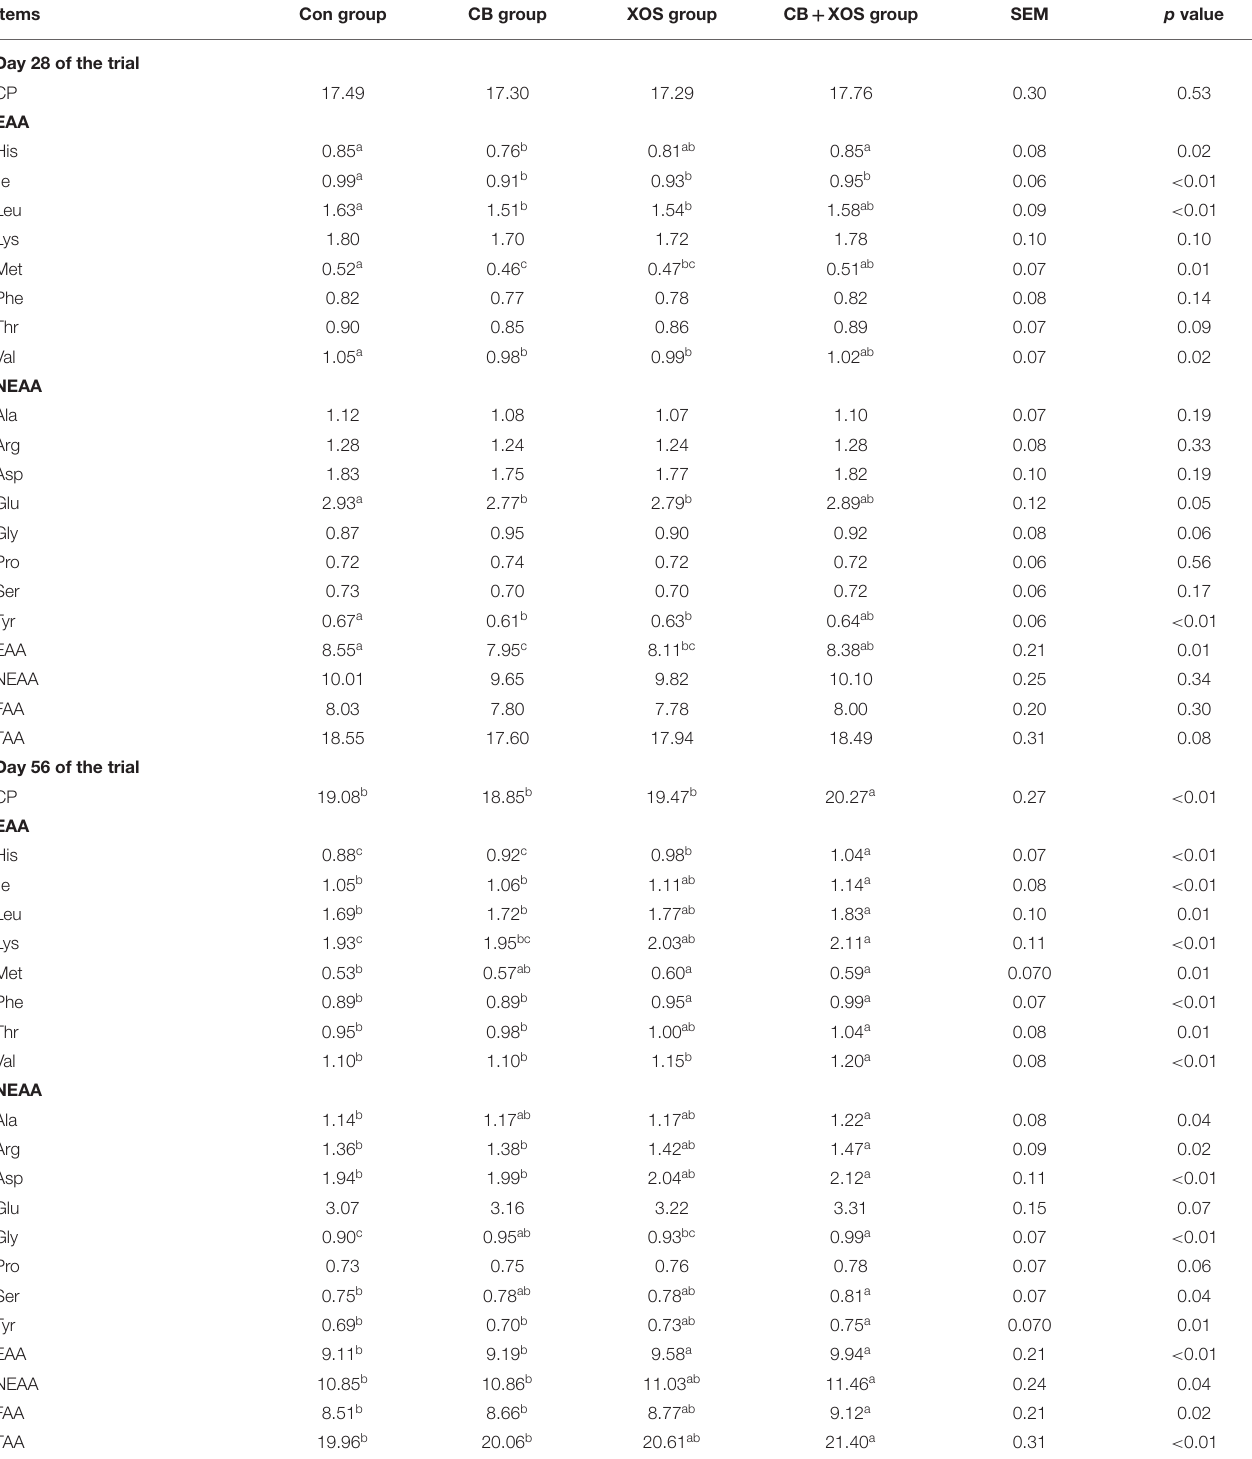
TABLE 5 | Effects of dietary addition with CB and XOS on crude protein (CP) content and amino acid composition of longissimus dorsi muscle of Huanjiang mini-pigs (100g fresh